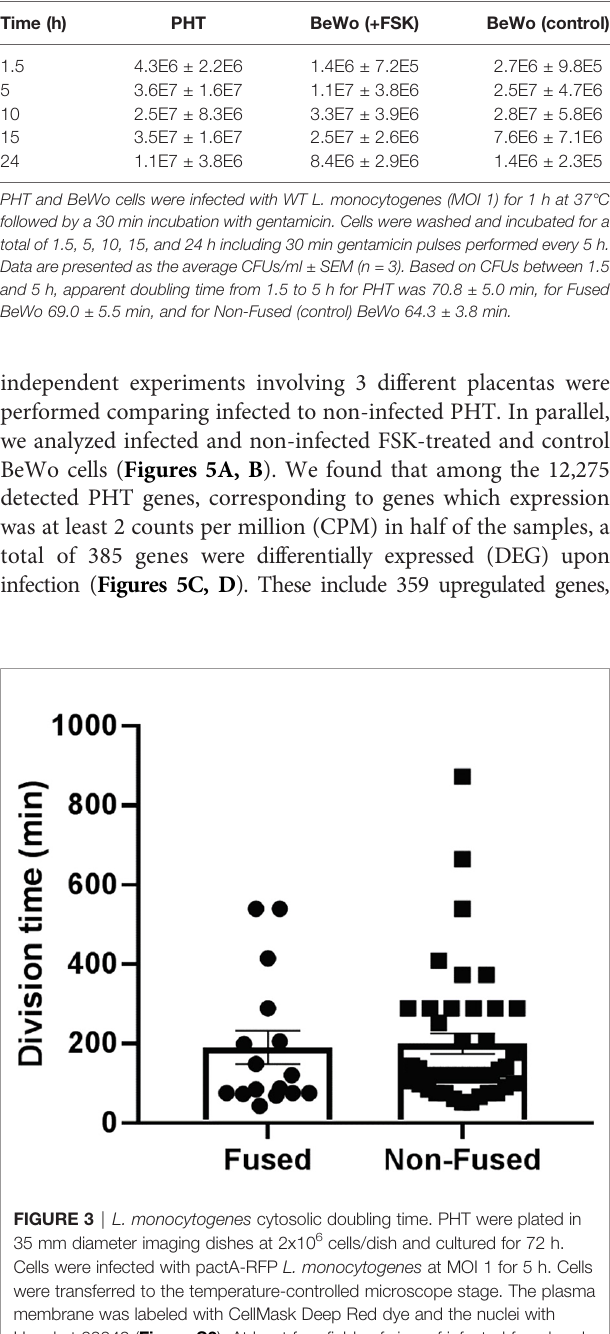
TABLE 1 | Gentamicin survival assay.